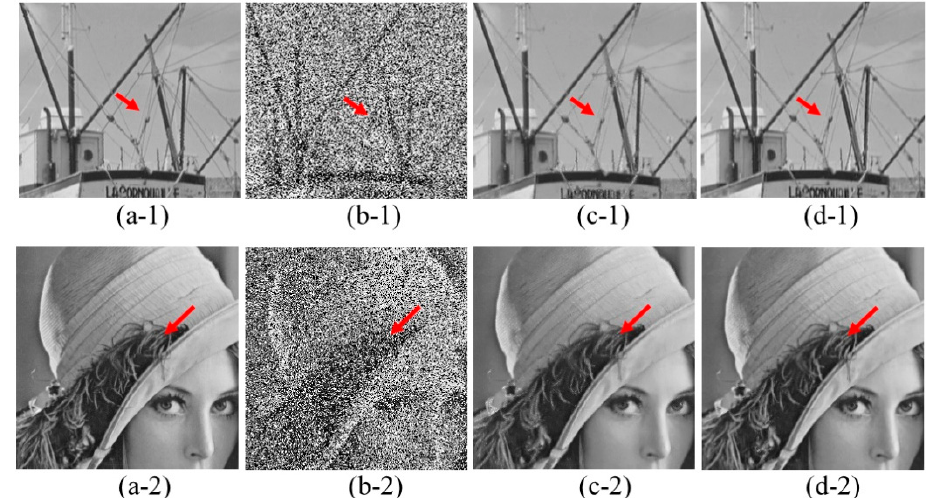
Figure 7. Comparisons on denoised images using FDLCP-L 1 and FDLCP-L 0 . ( a ) and ( b ) are noise-free and noisy images, ( c ) and ( d ) are denoised images using FDLCP-L 1 and FDLCP-L 0 , respectively. The first row and the second row are Boat and Lena images. Note: The salt and pepper noise level is 0.5 and the denoised Barbara images is shown in Figure 3.